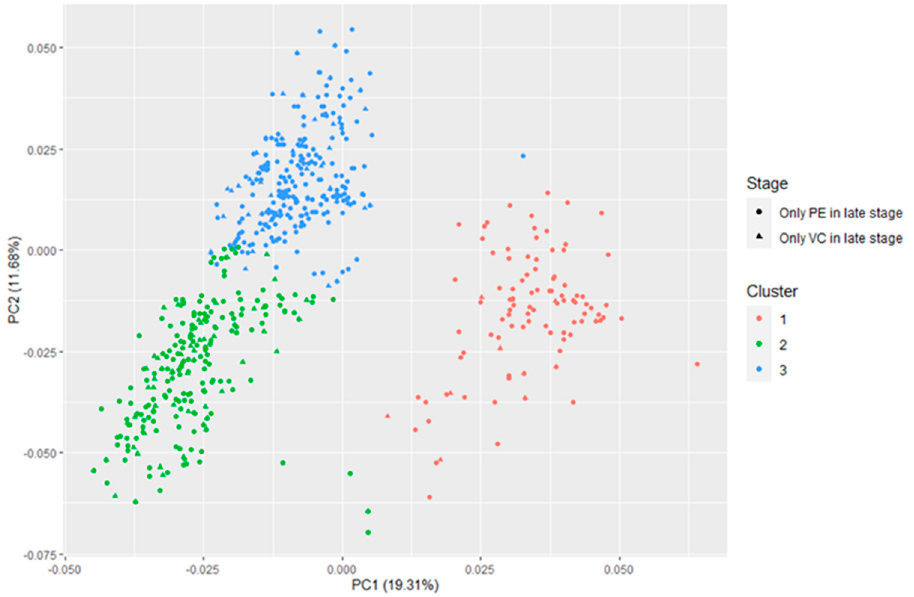
Figure 2. 1363 companies clustered by industry group similarity. 3 Clusters were found. Table 3. Later Stage Companies by Cluster and Funding Type . Cluster